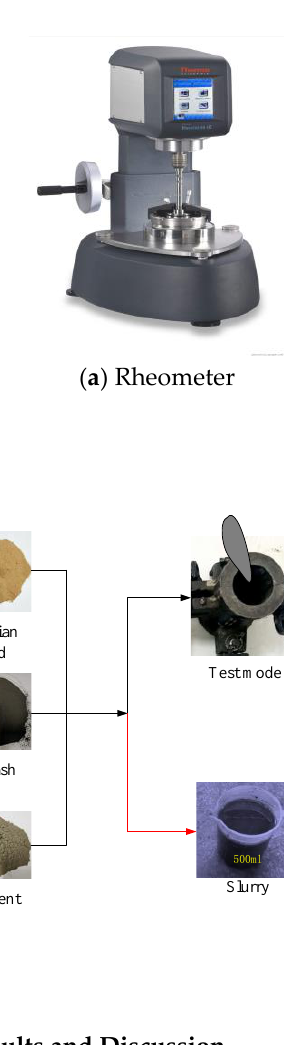
Figure 4. Experimental flowchart. Table 5. Experimental Table 5. Experimental data.